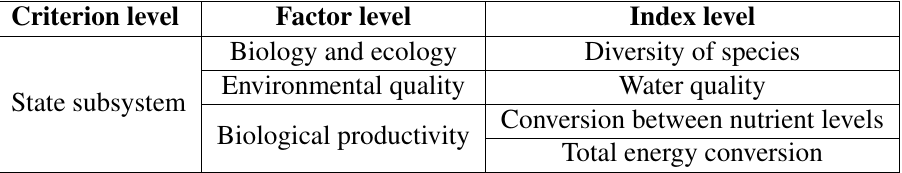
Table 2 Evaluation index selection of the state subsystem.